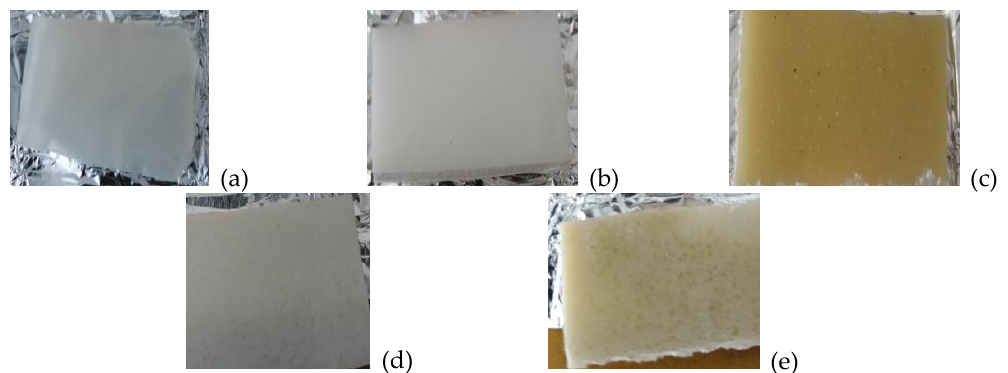
Figure 1. Sheet images for low density polyethylene (LDPE) composites: ( a ) LDPE/ultra-high molecular weight polyethylene (UHMWPE); ( b ) LDPE/hydroxyapatite (HAp); ( c ) LDPE/HAp/rosemary (RM); ( d ) LDPE/UHMWPE/HAp; ( e ) LDPE/UHMWPE/ HAp/RM.